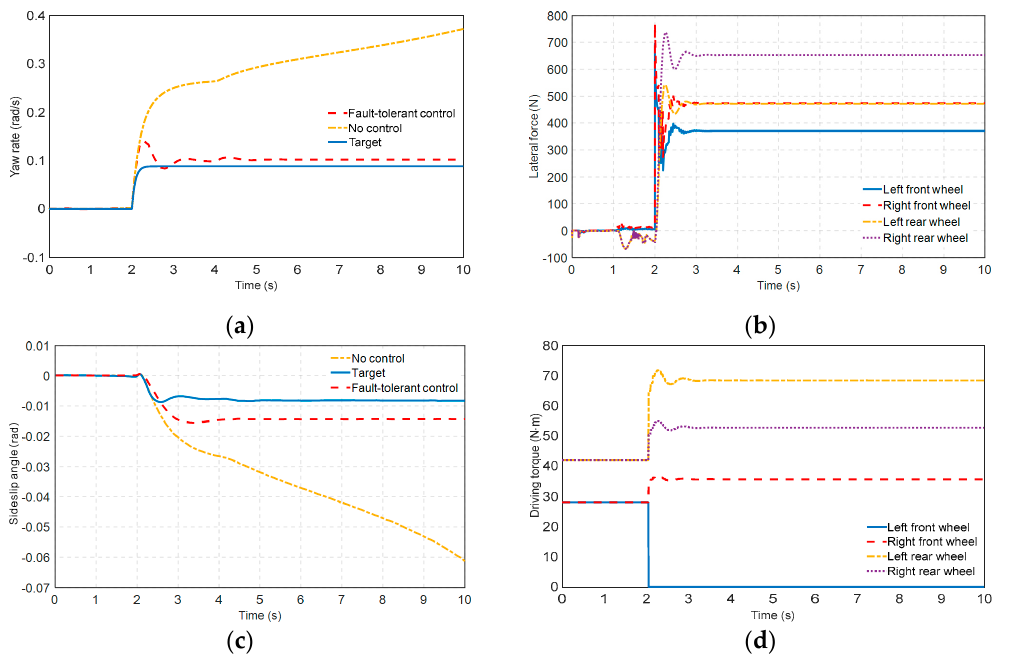
Figure 6. Results of the single-wheel failure in the angular step steering: ( a ) Yaw rate; ( b ) Lateral force; ( c ) Sideslip angle; ( d ) Drive torque.